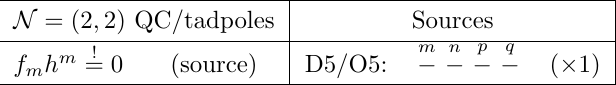
Table 16 . Non-vanishing extra QC (3.8) and their higher-dimensional origin for the (cid:13)ux com- pacti(cid:12)cation of type IIB with O5/D5 given in table 14, where BI stands for Bianchi identities and ~d (cid:17) d + ! ^ . A description of the QC as restrictions for the existence of additional local sources is